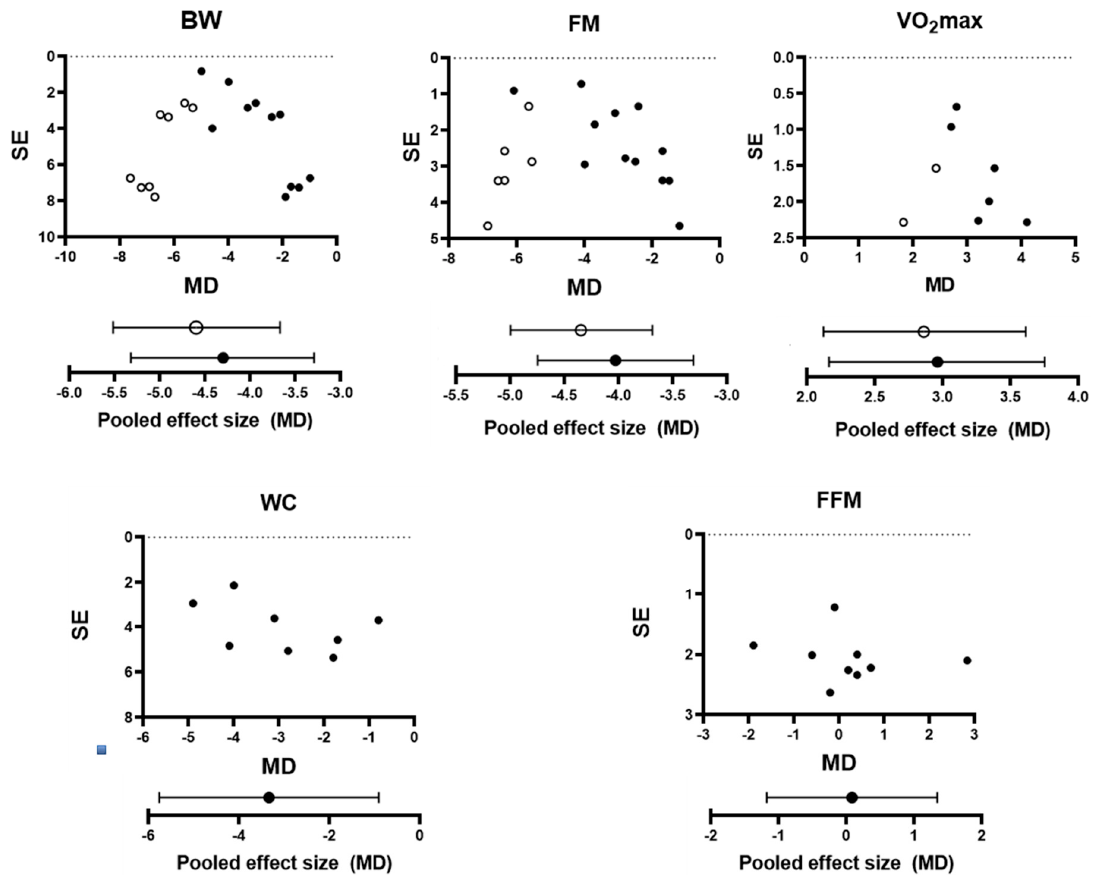
Figure A2. Top panels are the funnel plots for observed mean differences. Solid circles are original data; open circles are imputed filled values. For BW, FM, and VO 2 max, bottom panels show the pooled effect sizes and 90% CI of mean differences before (solid circles) and after adjusted for publication bias (open circles).